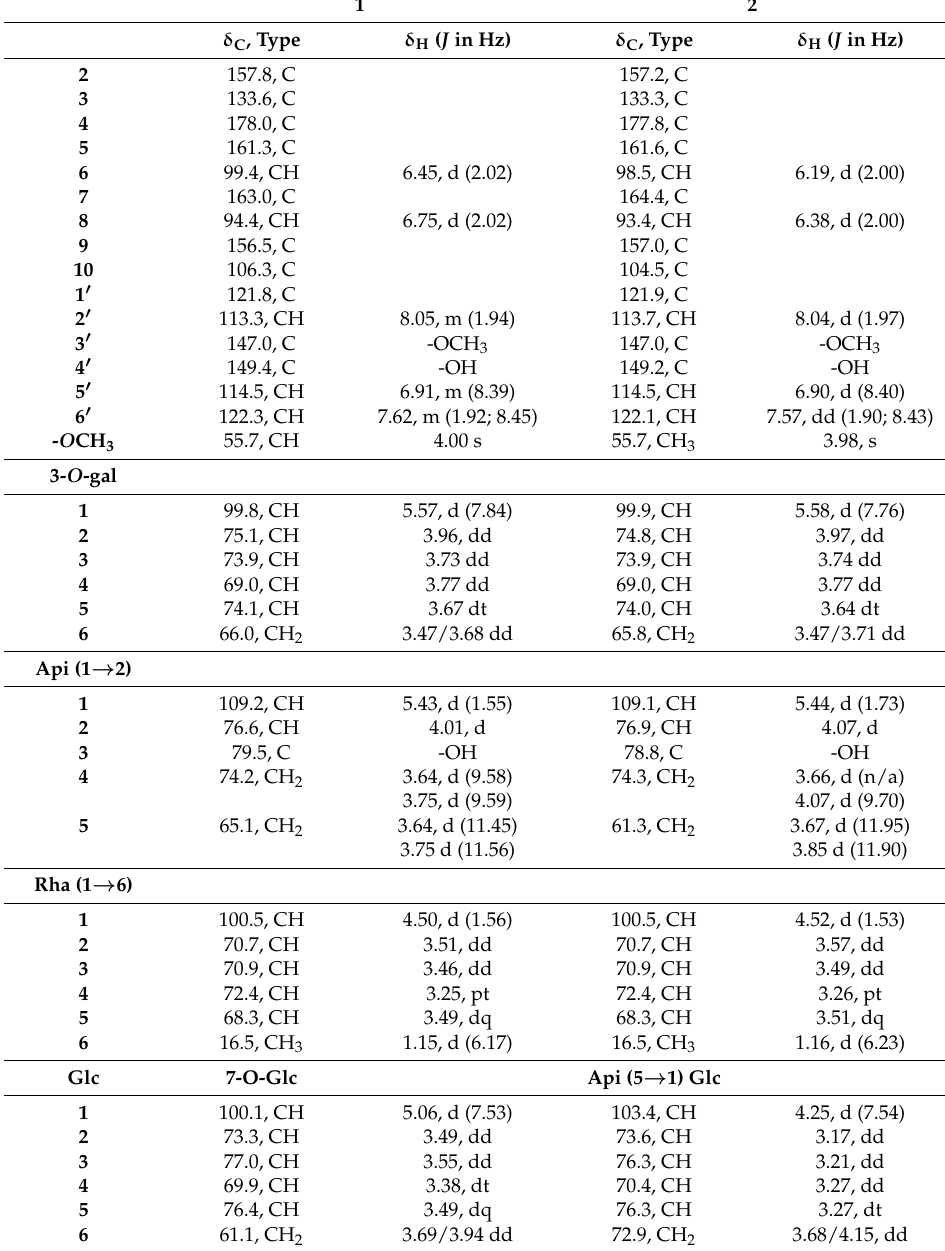
Table 1. 13 C-NMR δ C (ppm) (100 MHz); 1 H-NMR (600 MHz for 1 and 500 MHz for 2 ). δ H (ppm), multiplicity ( J in